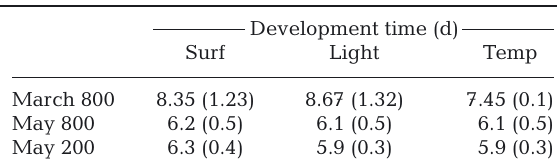
Table 1. Simulated Lepeophtheirus salmonis . Develop - ment time to copepodite stage for the simulations ‘Surf’ (copepodites fixed at the surface), ‘Light’ (vertical migration controlled by light and salinity), and ‘Temp’ (temperature- controlled vertical migration), presented as mean number of days, with variance ( σ 2 ) shown in parentheses, for March and May in the 800 m resolution model, and for May in the 200 m resolution